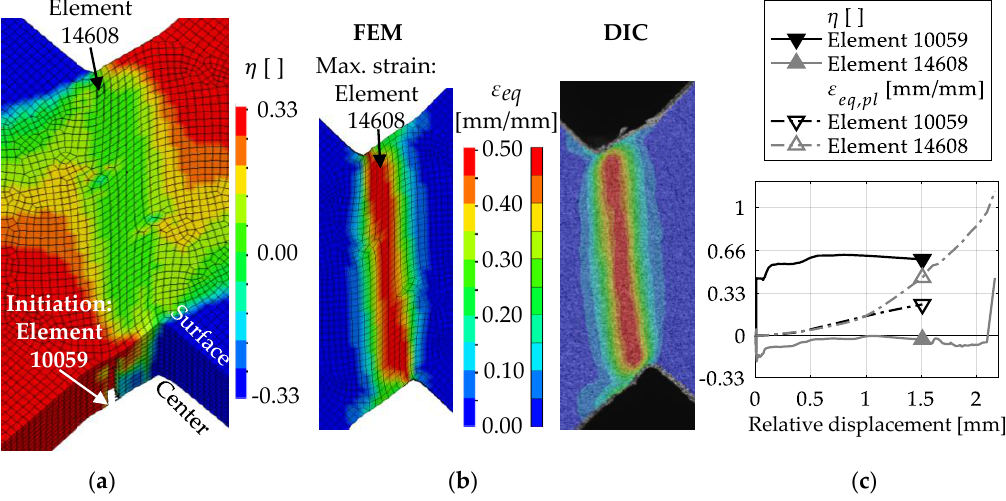
Figure 10. Stress triaxiality and strain within Z1 in shear tests: ( a ) 𝜂 at 1.7-mm displacement and